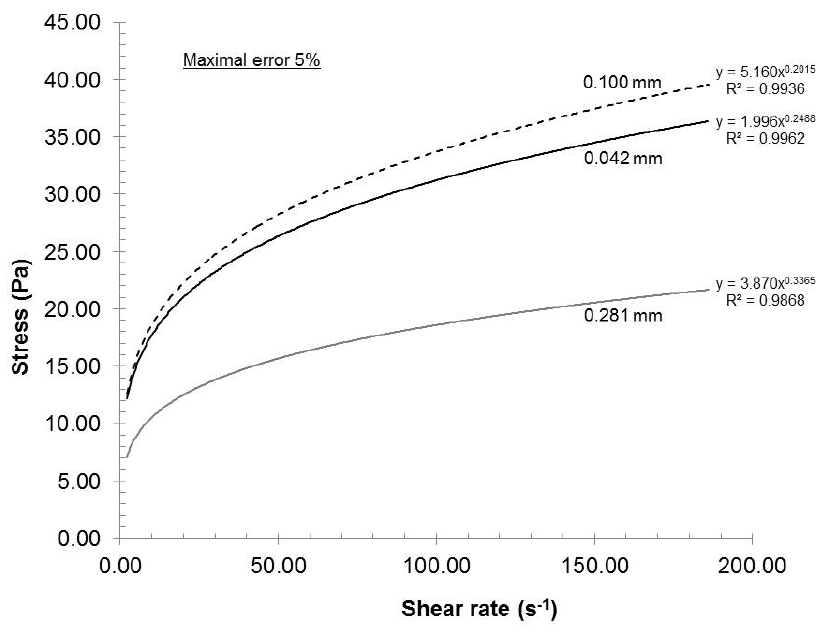
Figure 5. Effect of stator-rotor gap on the rheological evolution of the gels.